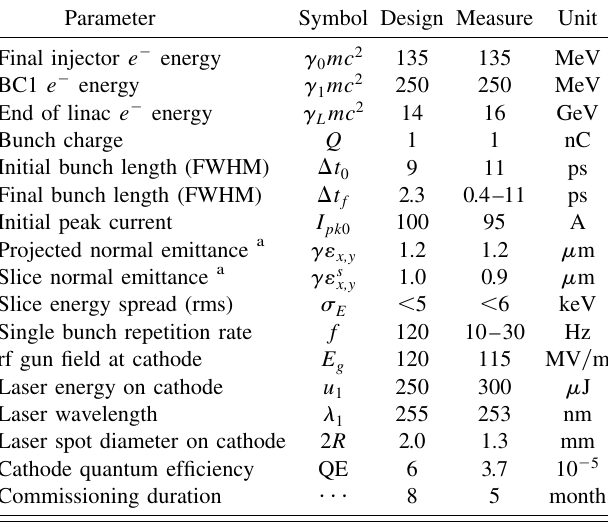
TABLE I. Design and typical measured